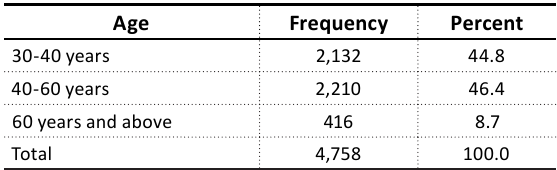
Table 4. Age distribution of households